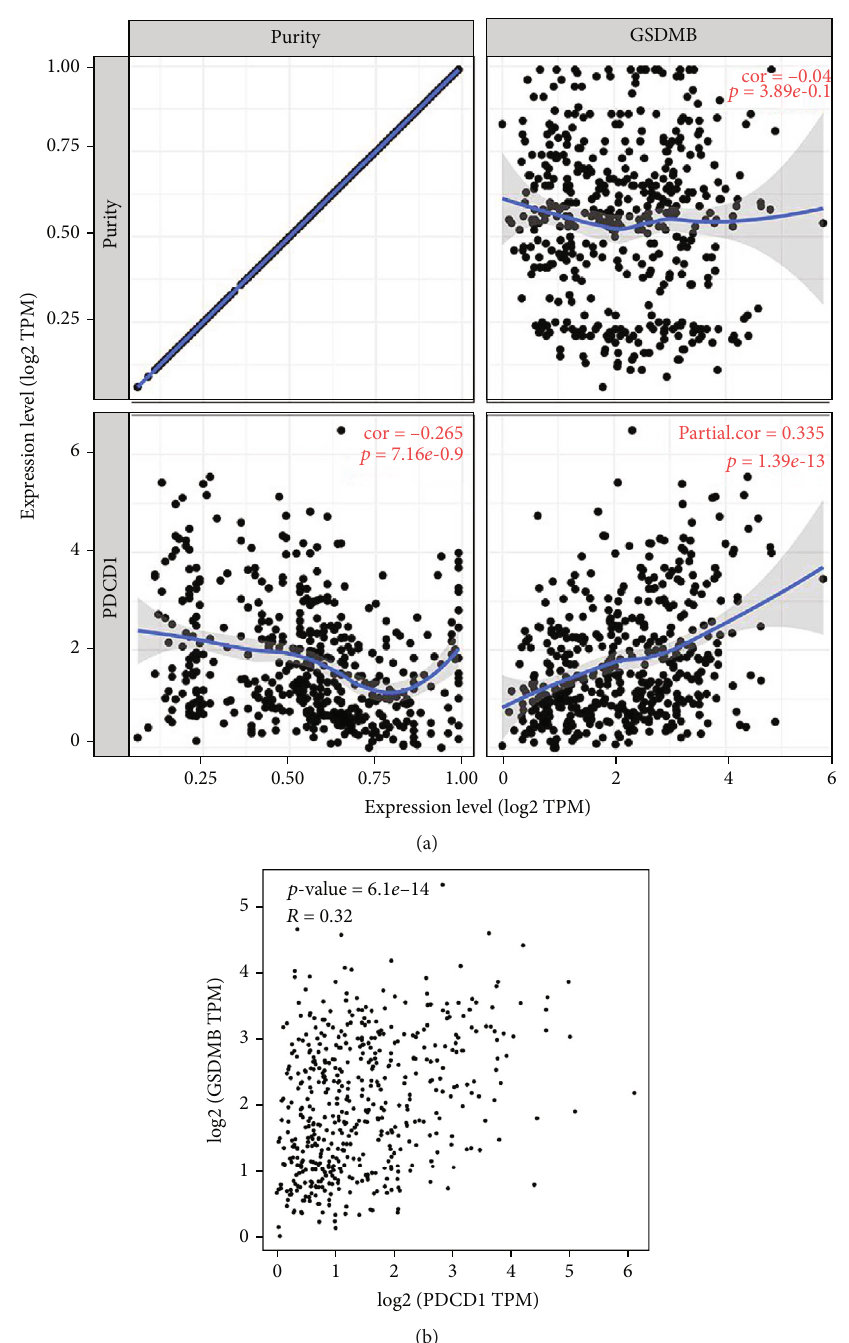
Figure 9: Relationship between GSDMB and PD1 in ccRCC. (a) Spearman correlation of GSDMB with expression of PD-1 in ccRCC adjusted by purity using TIMER. (b) The expression correlation of GSDMB with PD-1 in ccRCC determined by the GEPIA database. ccRCC: clear cell renal cell